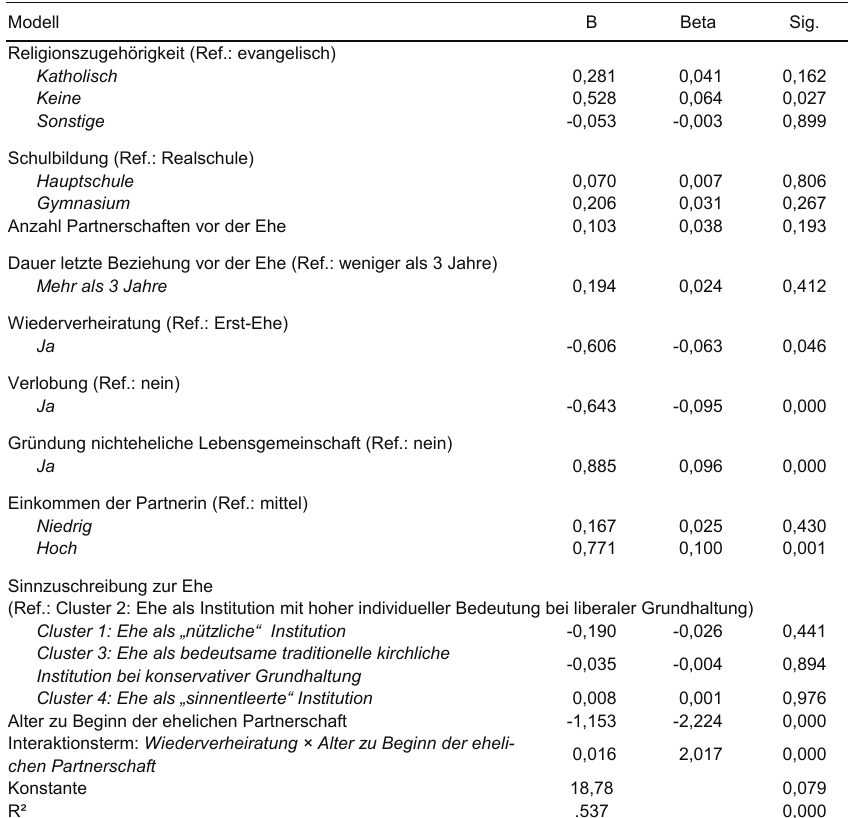
Tab. 7: Faktoren der Partnerschaftsdauer bis zur Heirat Modell B Beta